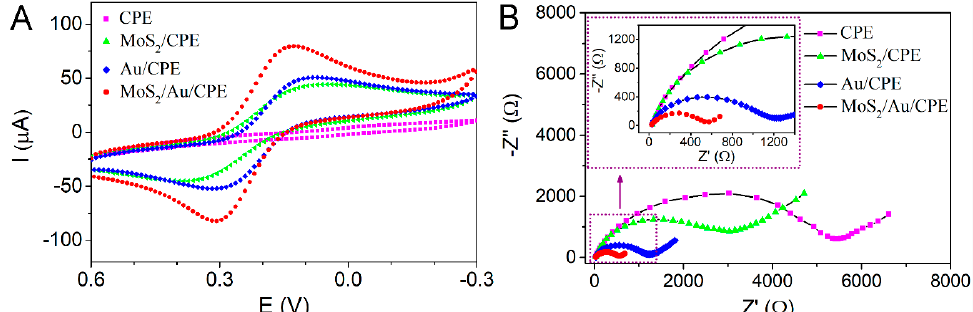
Figure 2. The ( A ) CV and ( B ) EIS curves recorded at bare CPE, MoS 2 /CPE, Au/CPE and MoS 2 /Au/CPE in 1.0 mM [Fe(CN) 6 ] 3 − /4 − solution (pH 7.0).